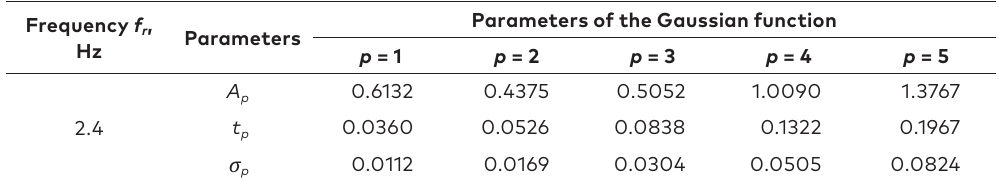
Table 4. Parameters of the template for running frequency of 2.4 Hz